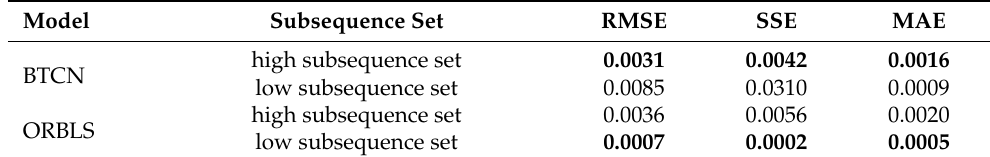
Table 4. Forecasting performances of BTCN and ORBLS.